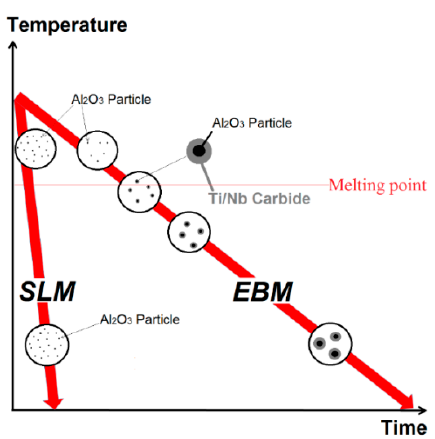
Figure 9. Schematic illustrating the cooling process of IN718 alloy fabricated by SLM and EBM, respectively.